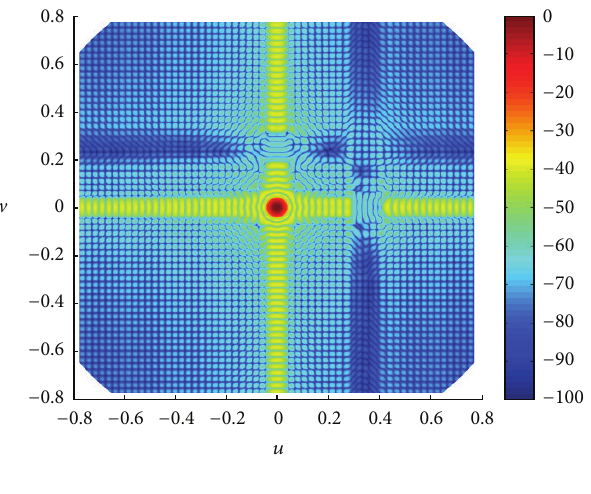
Figure 10: 2D radiation pattern.